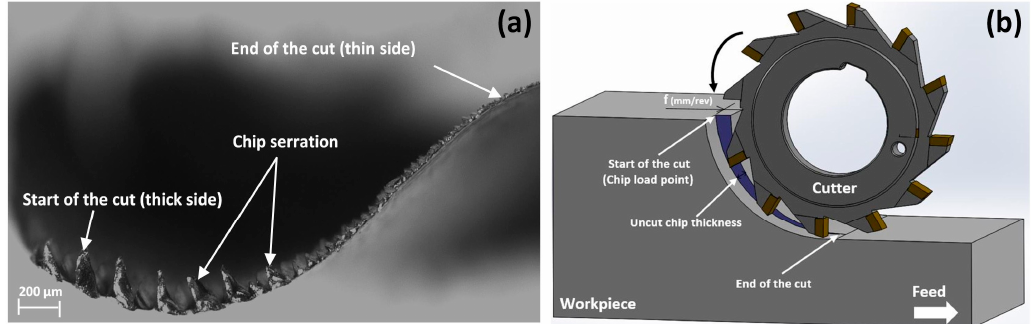
Figure 11. ( a ) Photograph of the produced chip; ( b ) schematic view of down-milling process.